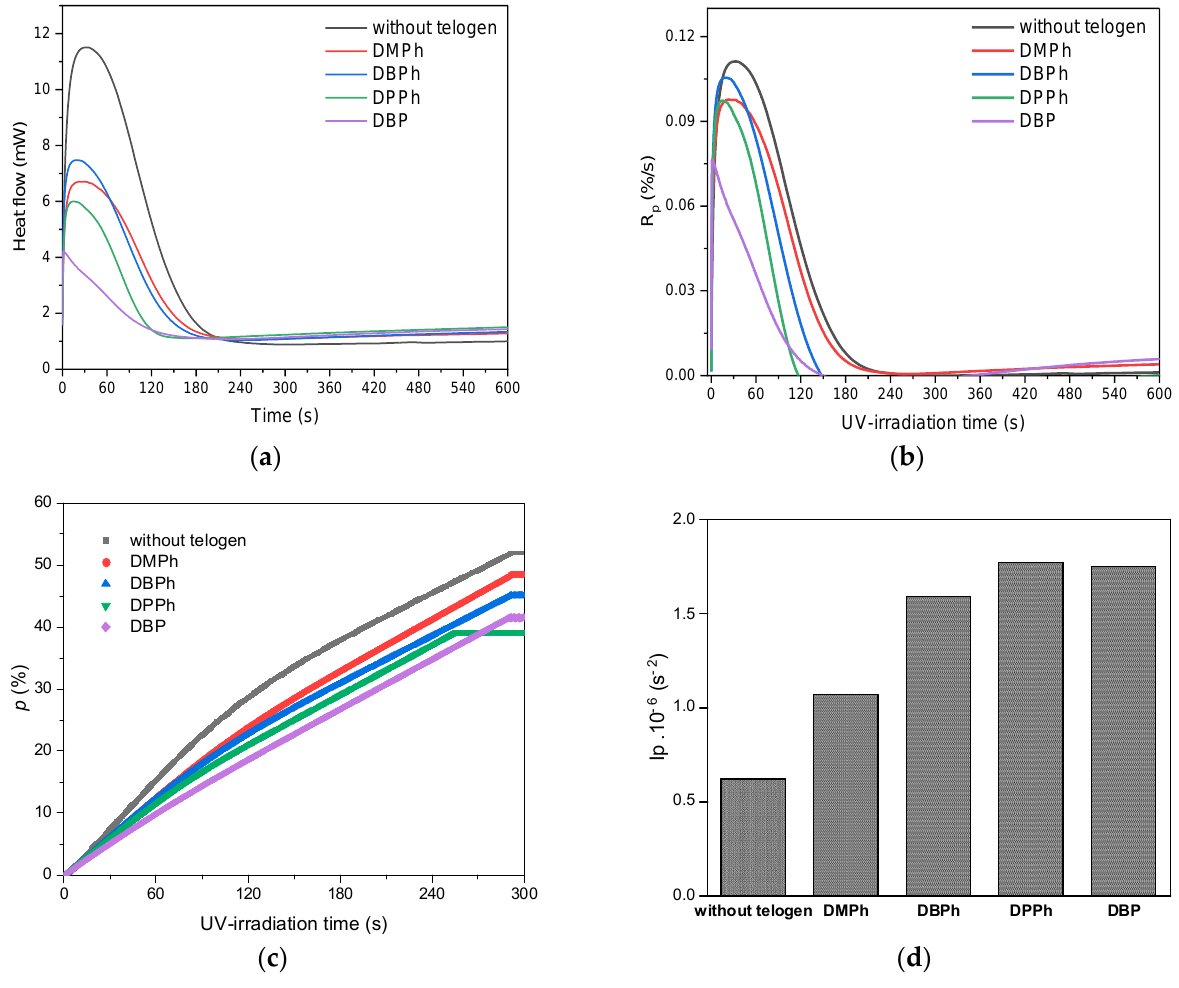
Figure 2. Photo-DSC curves ( a ), the reaction rate ( b ), double bond conversion ( c ), and photoinitiating index ( d ) during BA, MMA, HEA, and STY UV-phototelomerization process in the presence of different P-telogens (320–390 nm; I o = 15 mW/cm 2 ).